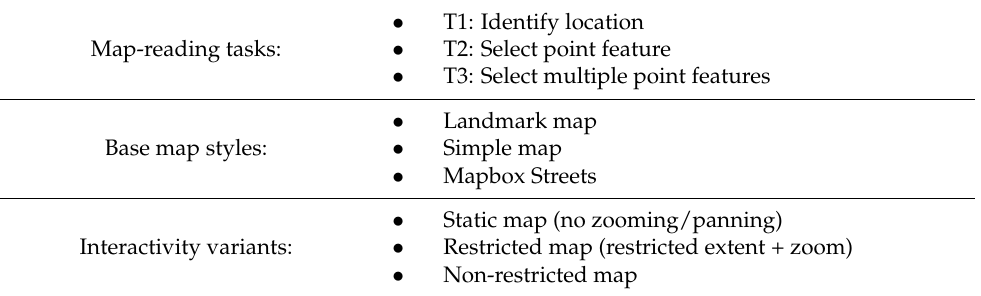
Table 2. Map-reading tasks, base map styles, and interactivity